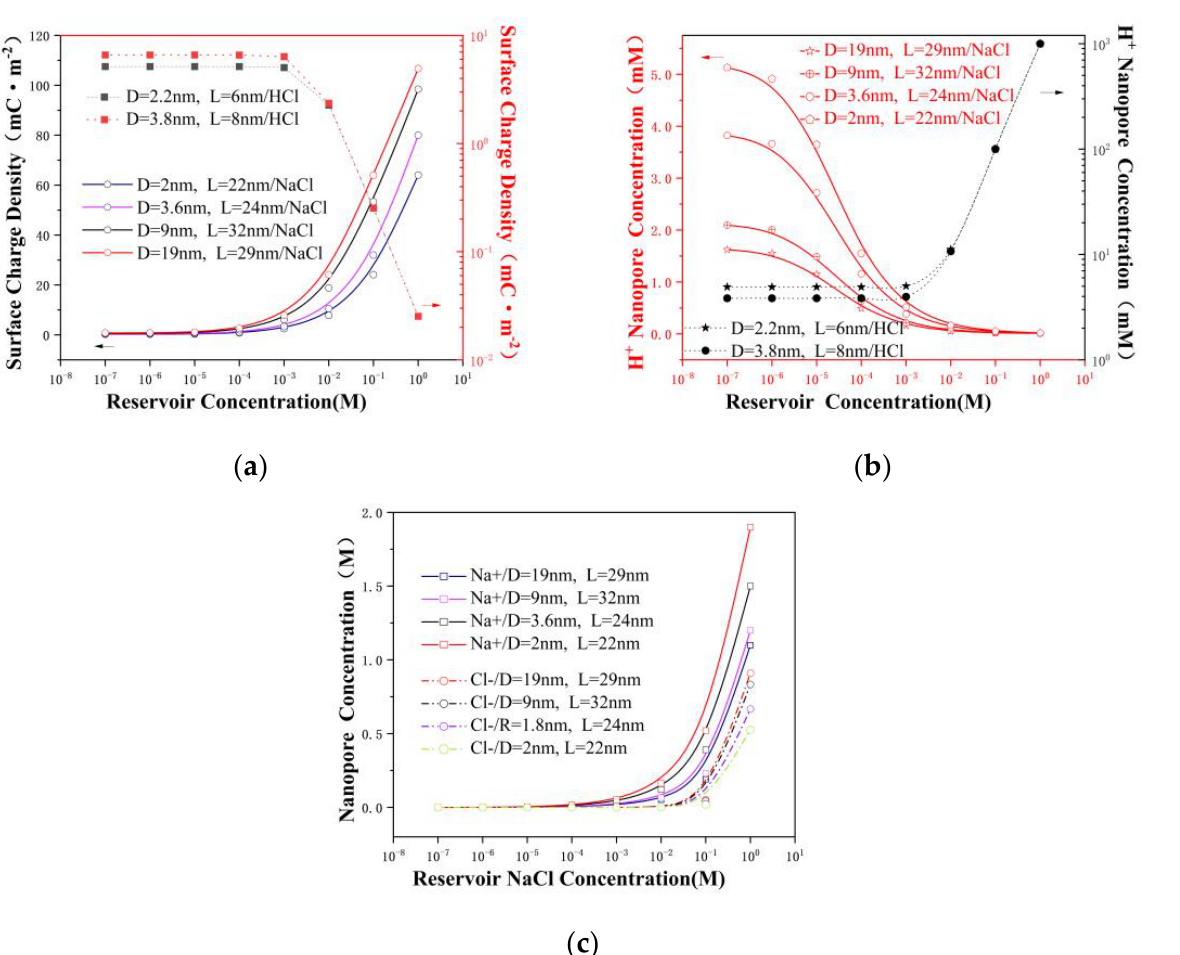
Figure 4. Ionic concentration inside the nanopore. ( a ) Surface charge density inside the nanopore for NaCl/HCl solutions. ( b ) H + concentration inside the nanopore. ( c ) Na + /Cl - concentration inside the nanopore.